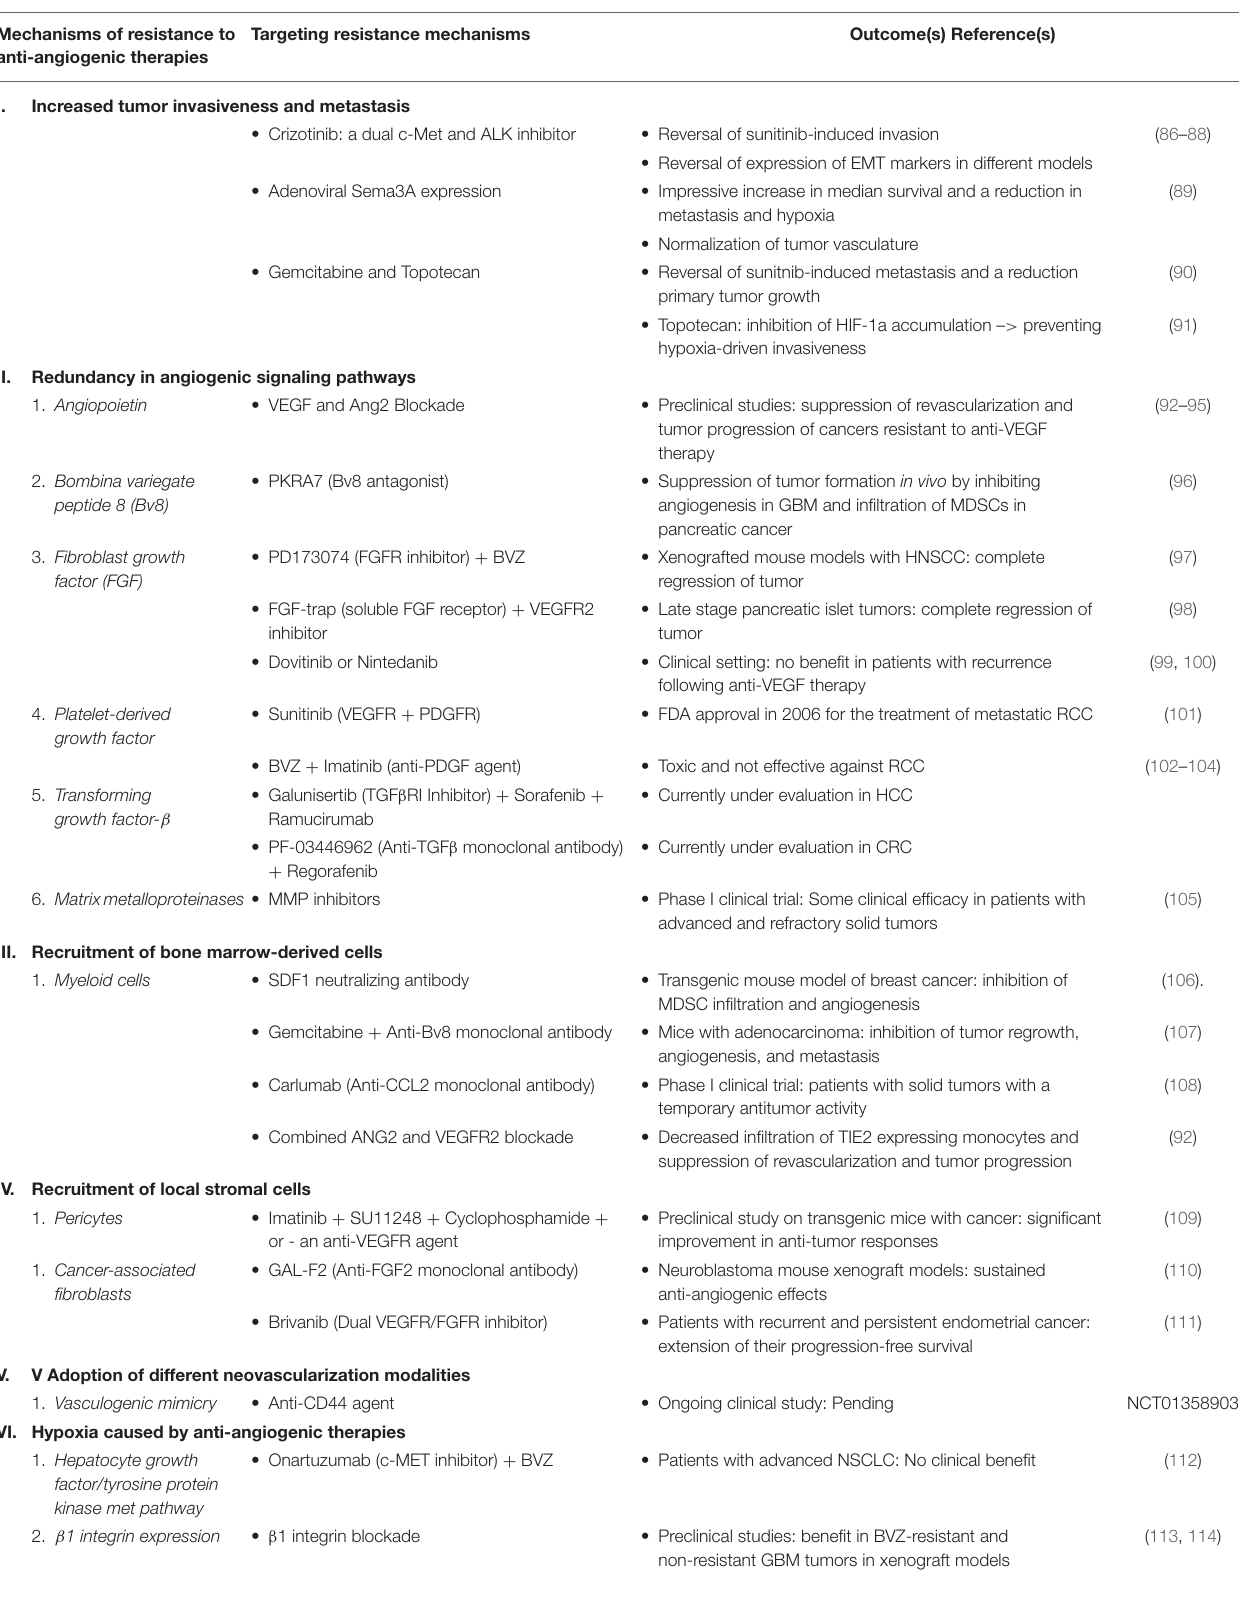
TABLE 3 | List of mechanisms of resistance to anti-angiogenic therapies and ways to target them along with the outcomes associated with each approach. Mechanisms of resistance to anti-angiogenic